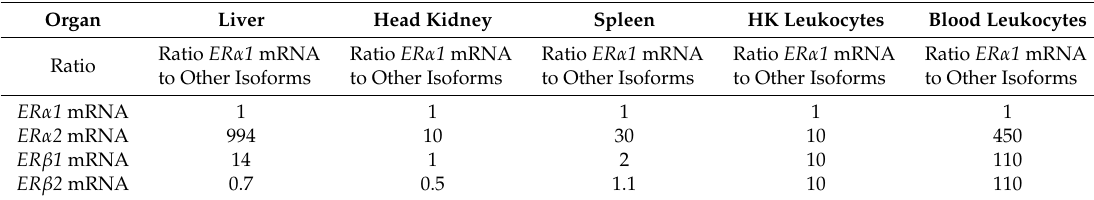
Table 1. The mRNA ratios of the four ER isoforms in liver, head kidney, spleen, head kidney leukocytes and blood